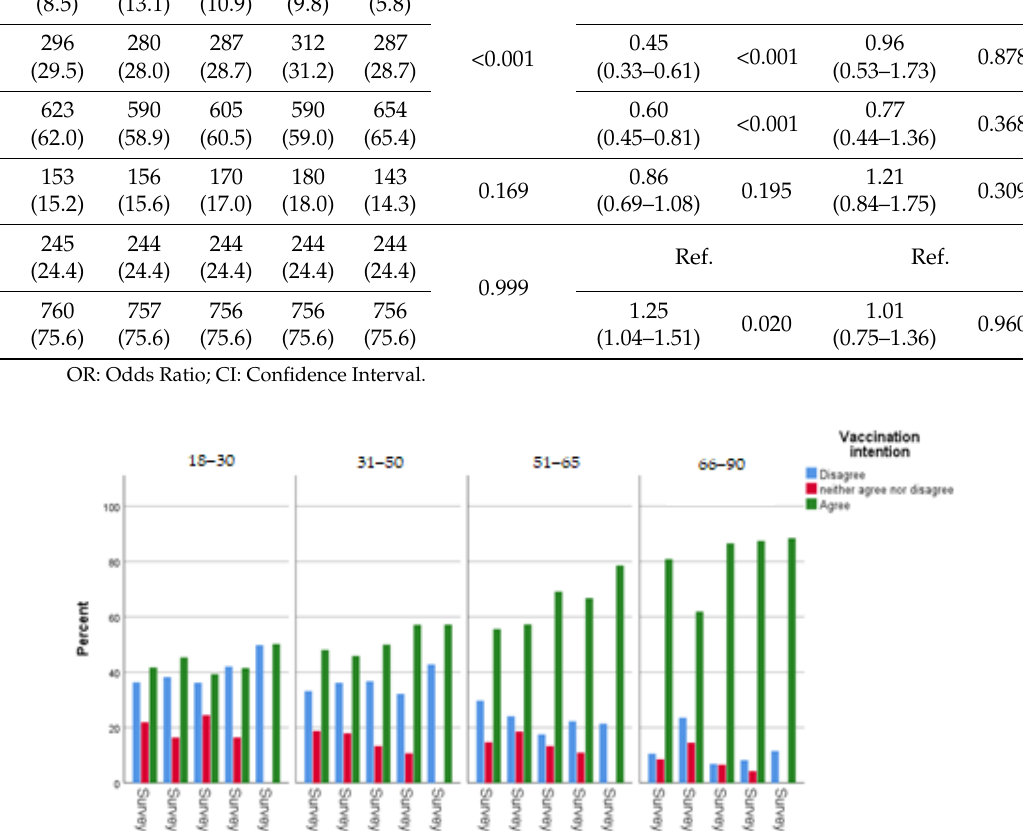
Figure 5. Years of education and vaccination intention across the surveys. Figure 6. Area of residence and vaccination intention across the surveys. 3.3. COVID-19 Infection Status The percentage of confirmed infected participants, confirmed infected contacts of participants, and COVID-19 vaccination intention increased significantly across surveys ( p = 0.006, <0.001 and <0.001, respectively). A statistically significant positive association was observed between the number of confirmed infected contacts of participants and